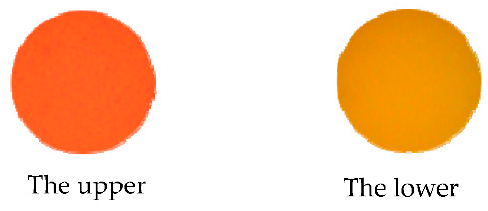
Figure 13. Experimental picture of Slide 1. Table 4. Experimental data of the thickness of Slide 1.